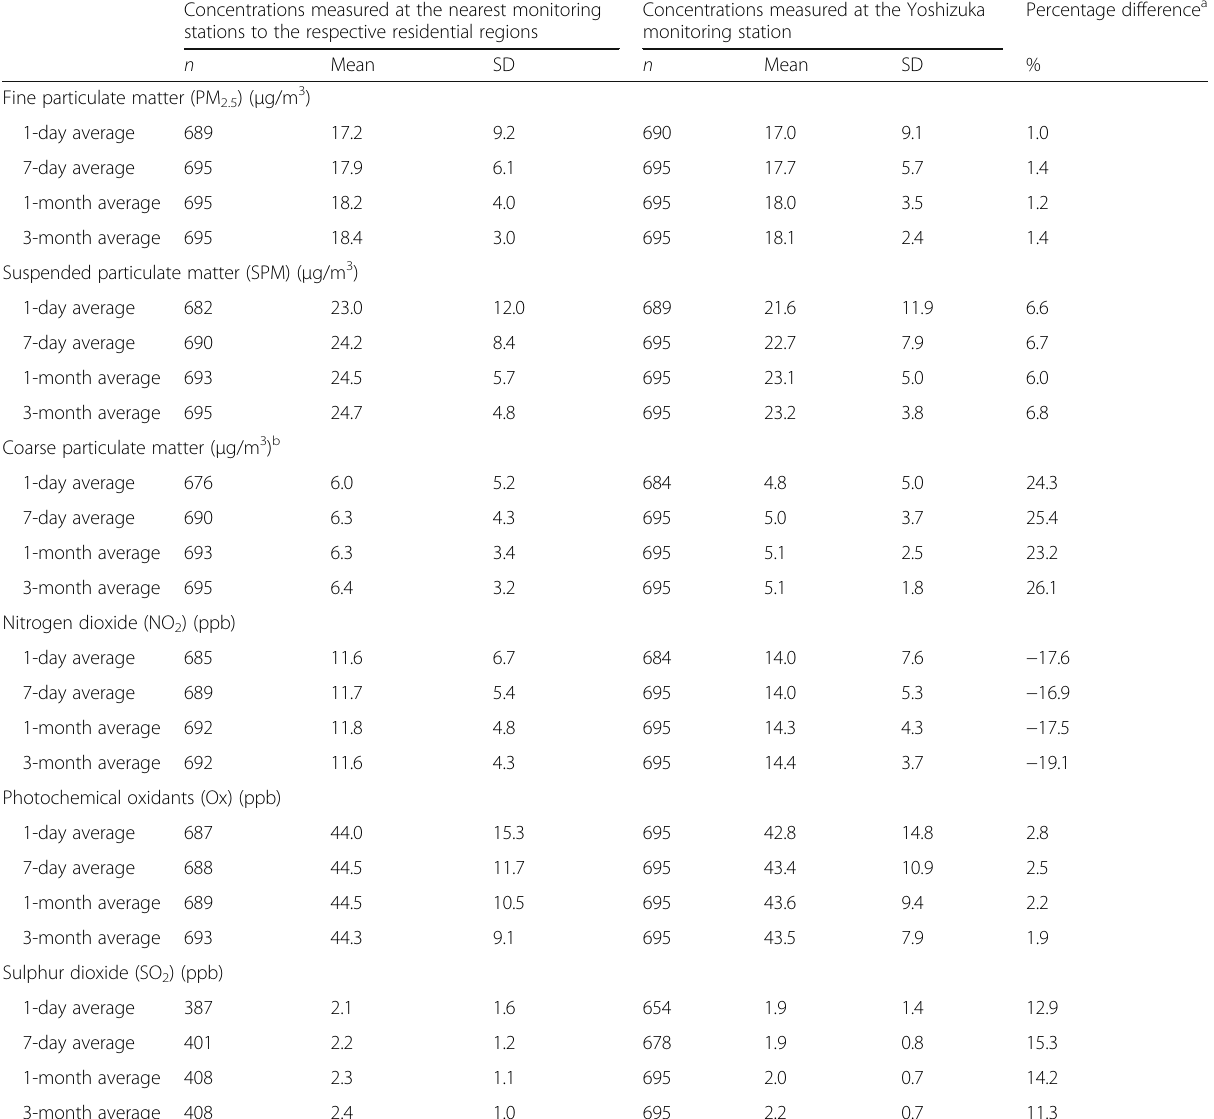
Table 3 Comparisons between pollutant concentrations measured at the Yoshizuka monitoring station and those at the nearest monitoring stations to the respective residential postal code regions Concentrations measured at the nearest monitoring Concentrations measured at the Yoshizuka Percentage difference stations to the respective residential regions monitoring station